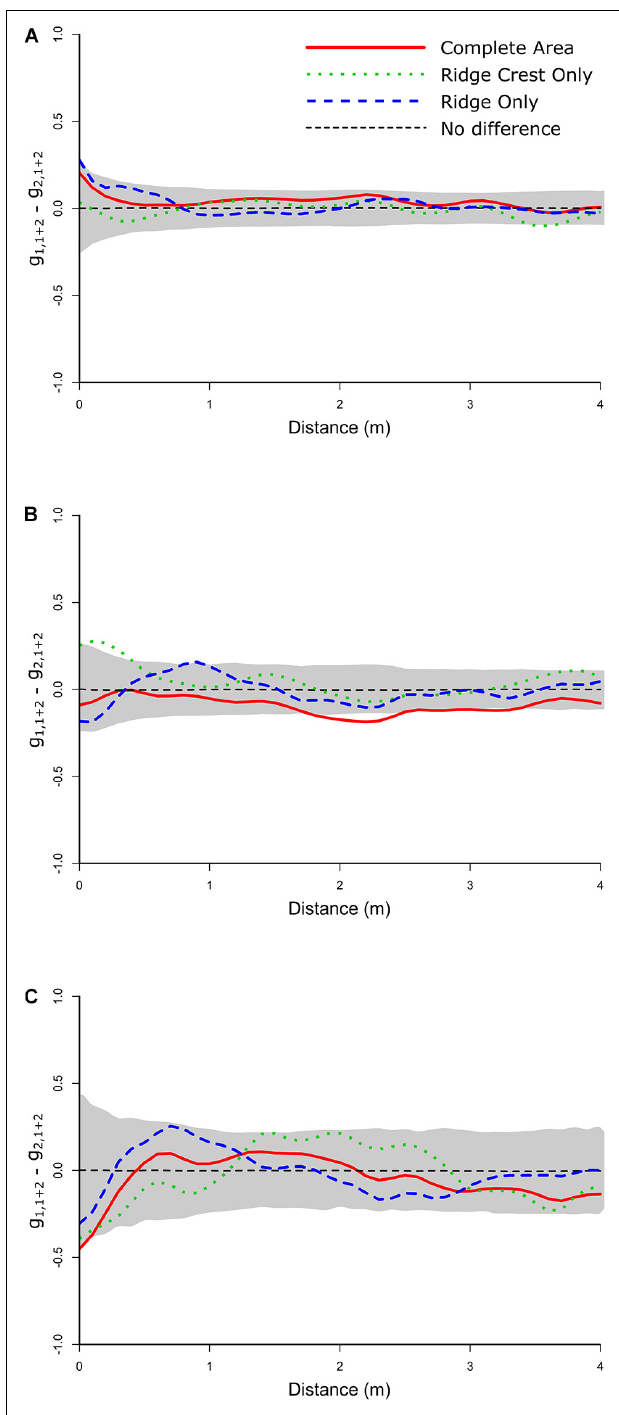
FIGURE 4 | Random labeling analyses plots showing the Quotient test. (A) Whole community analyses of the dead population relative to the alive population (including all corals and sponges mapped) showing no significant deviations from zero. (B) The Aspidoscopulia analyses of dead vs. alive specimens. Note the whole community and the Ridge Crest sub-section both show excursions outside the simulation envelopes. (C) The Advhena magnifica analyses of dead vs. alive specimens showing no significant deviations from